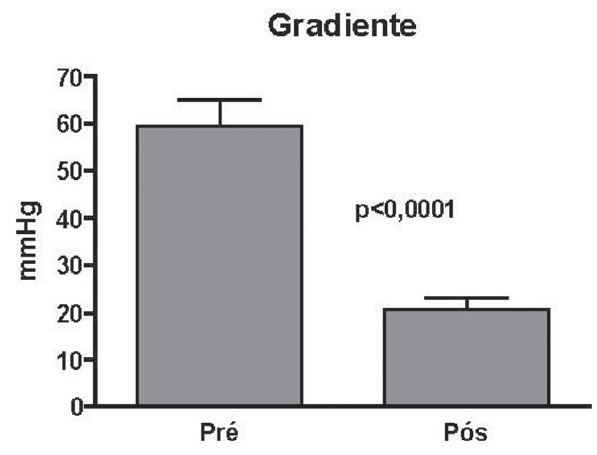
Fig. 2 - Gradientes pré e pós-operatórios